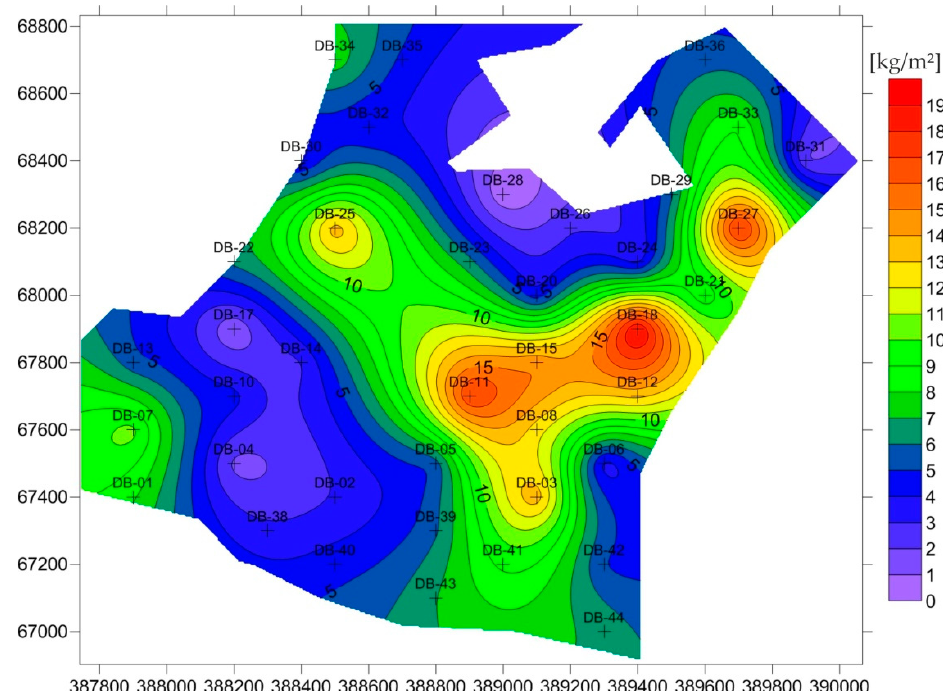
Figure 13. Cobalt resources (kg/m 2 ) for limonite and transition horizons. Inter- and extrapolation of data between exploration points performed for illustration purposes using the Radial Basis Function (RBF) method. WGS 84 UTM 52N coordinate system. Made in Surfer 9 software (Golden, CO, USA).